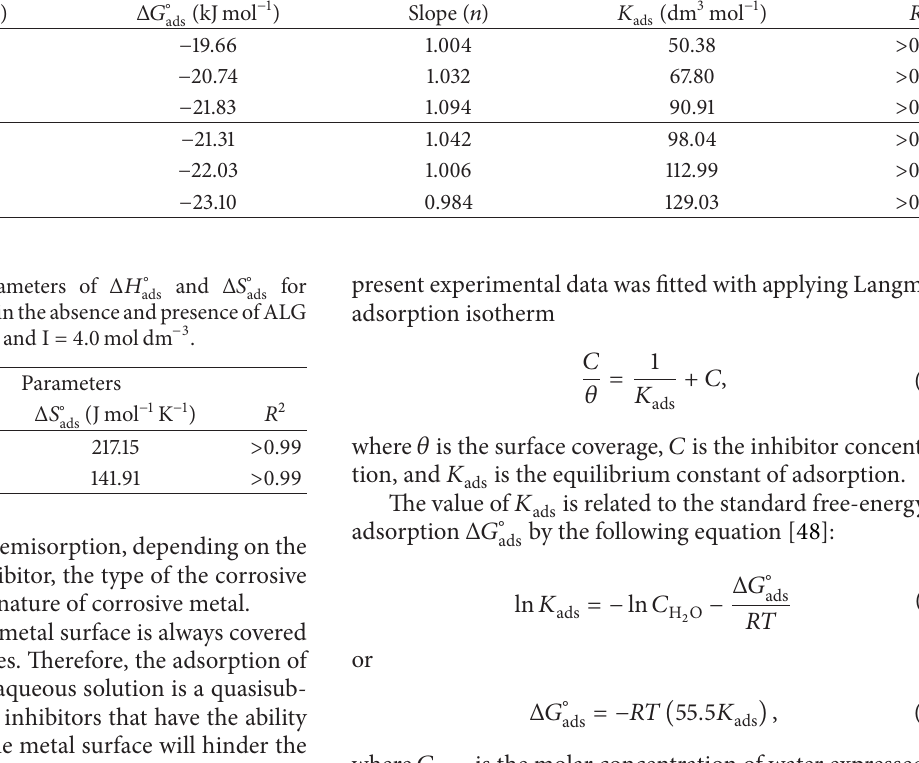
Table 4: Some kinetic parameters from Langmuir isotherm model for corrosion of Al in alkaline media. [OH − ] = 4.0 and I = 4.0 moldm − 3 . Inhibitor Temp. ( ∘ C)